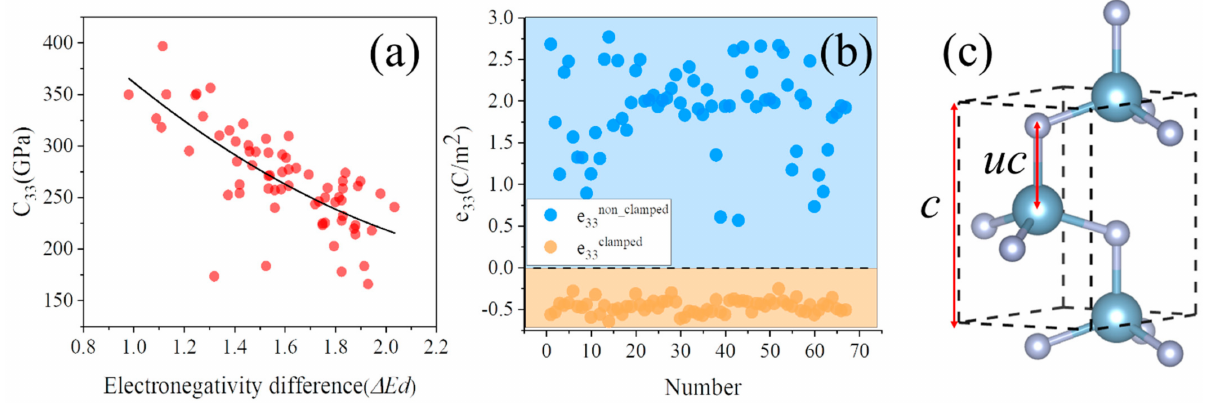
Figure 2. ( a ) The relationship of the C 33 and electronegativity difference. The result of the quadratic fitting is shown as a solid line. ( b ) The e 33 non_clamped and e 33 clamped of X 0.125 Y 0.125 Al 0.75 N. ( c ) Wurtzite structure with the internal parameter u = uc / c